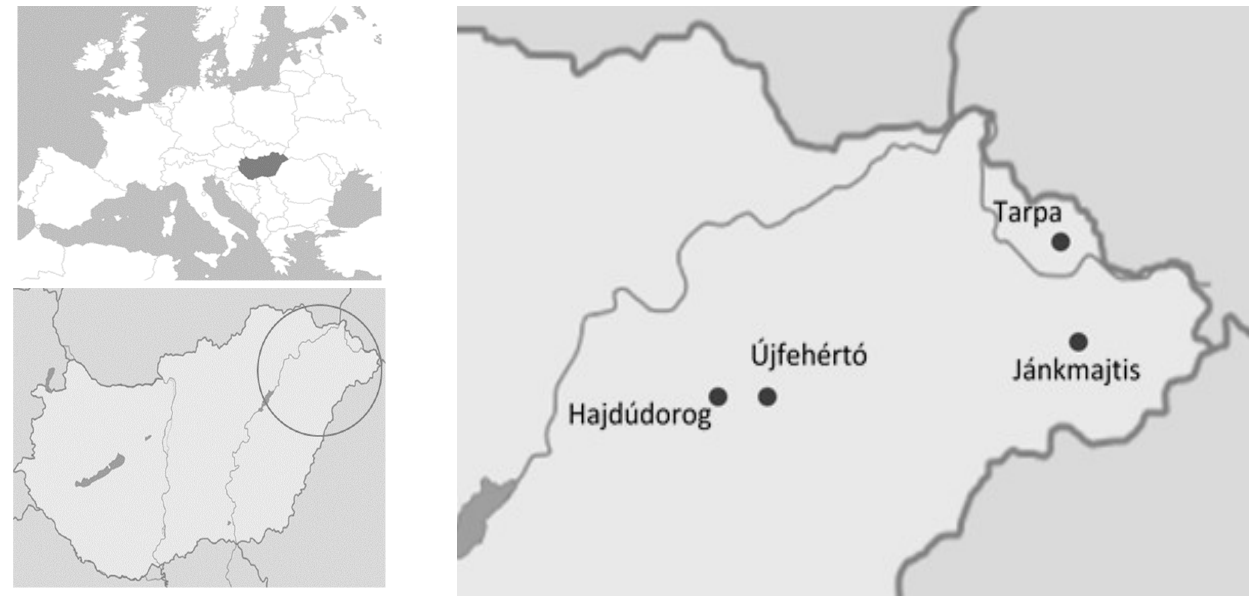
Figure 1. Location of the sampling sites of walnut trees in the north-east of Hungary (Szabolcs– Szatmár–Bereg and Hajdú–Bihar Counties). Table 1. The occurrence of Diplodia sp. and Diaporthe sp. in the collected plant samples. Preliminary taxonomical identification was based on the morphological attributes of the colonies growing on potato dextrose agar (PDA). No. of Samples